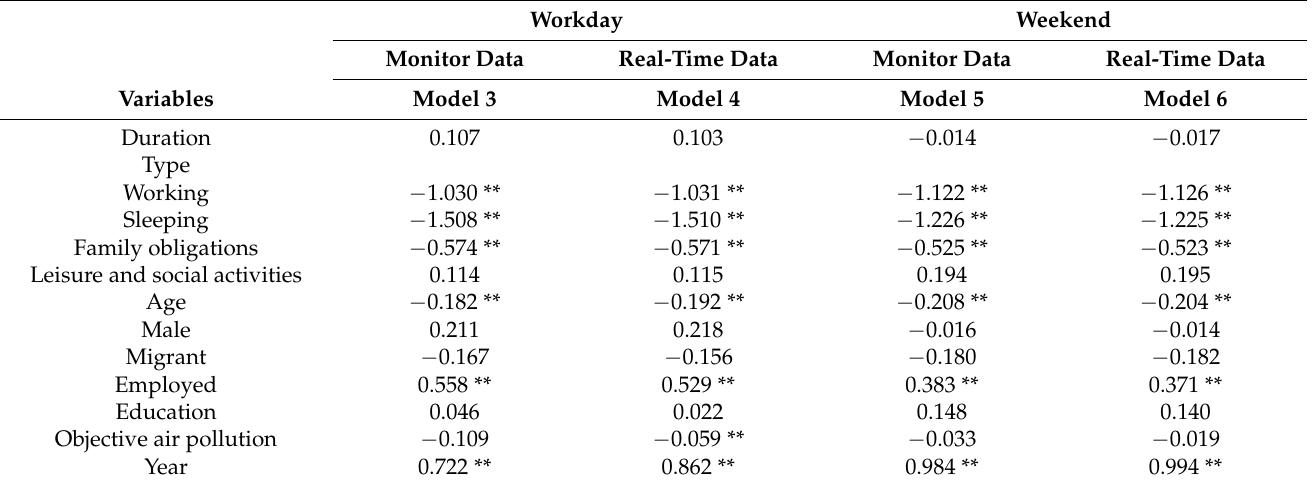
Table 3. Estimated coefficients of logistics models by workday and weekend.